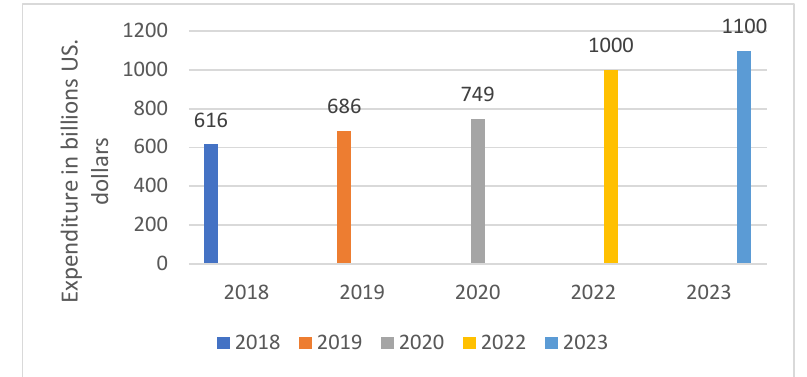
Figure 2. Worldwide expenditure on IoT from the year 2018–2023 [11].